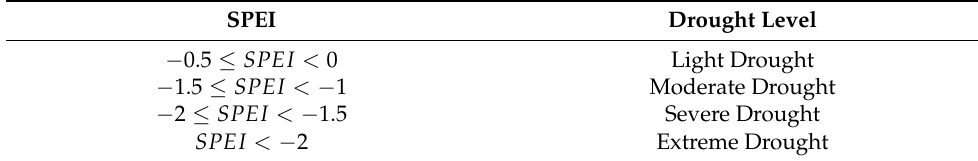
Table 3. Classification of Standardized Drought